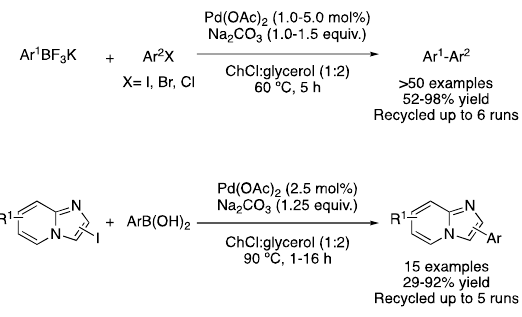
Figure 19. Ligand-free Suzuki couplings.